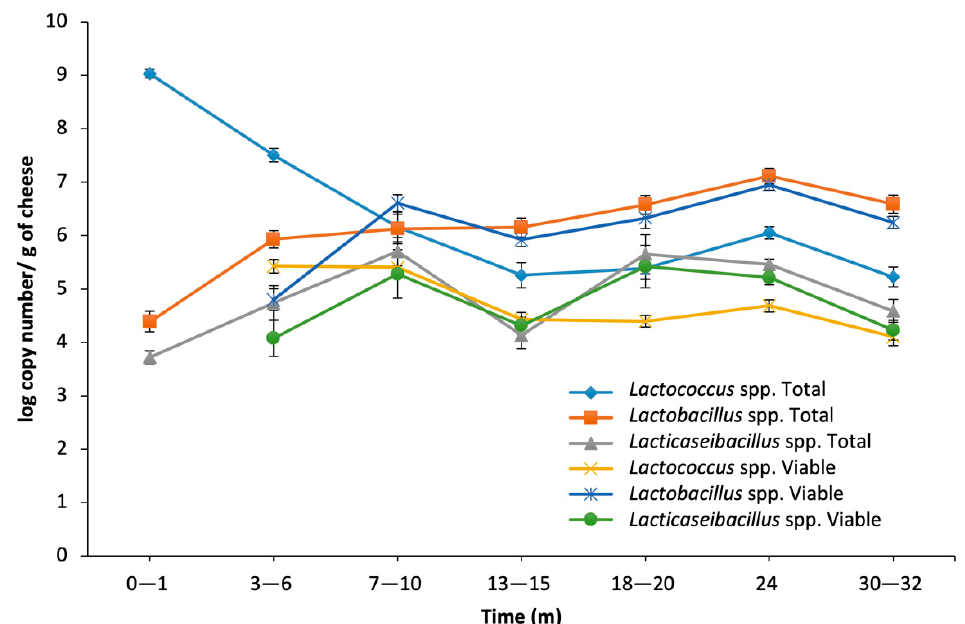
Figure 2. 16S rRNA log gene copy number of specific target bacterial genera, Lactococcus spp., Lactobacillus spp., and Lacticaseibacillus spp. (detected in 2 of 5 trials at 0–1 m) per g of cheese measured by qPCR of DNA from total and viable cells (PMA-treated) in cheese samples from five trials ripened to 32 months. Standard error applied to each data point.